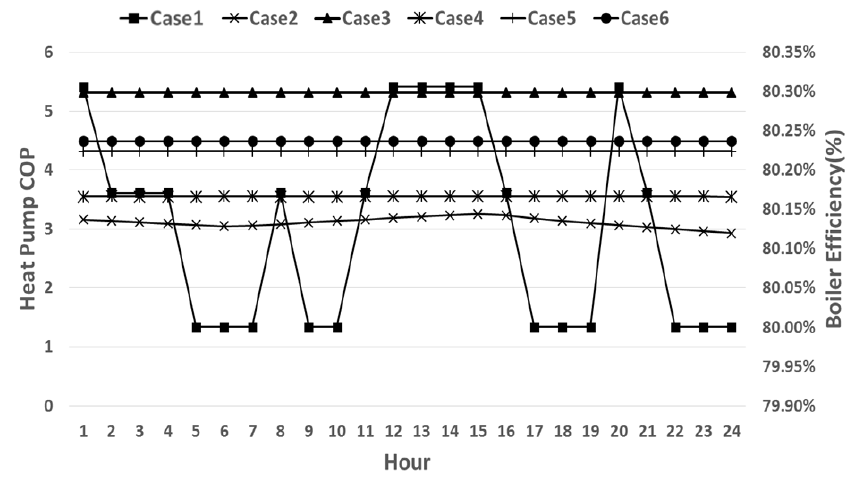
Figure 9. Boiler efficiency and heat pump COP